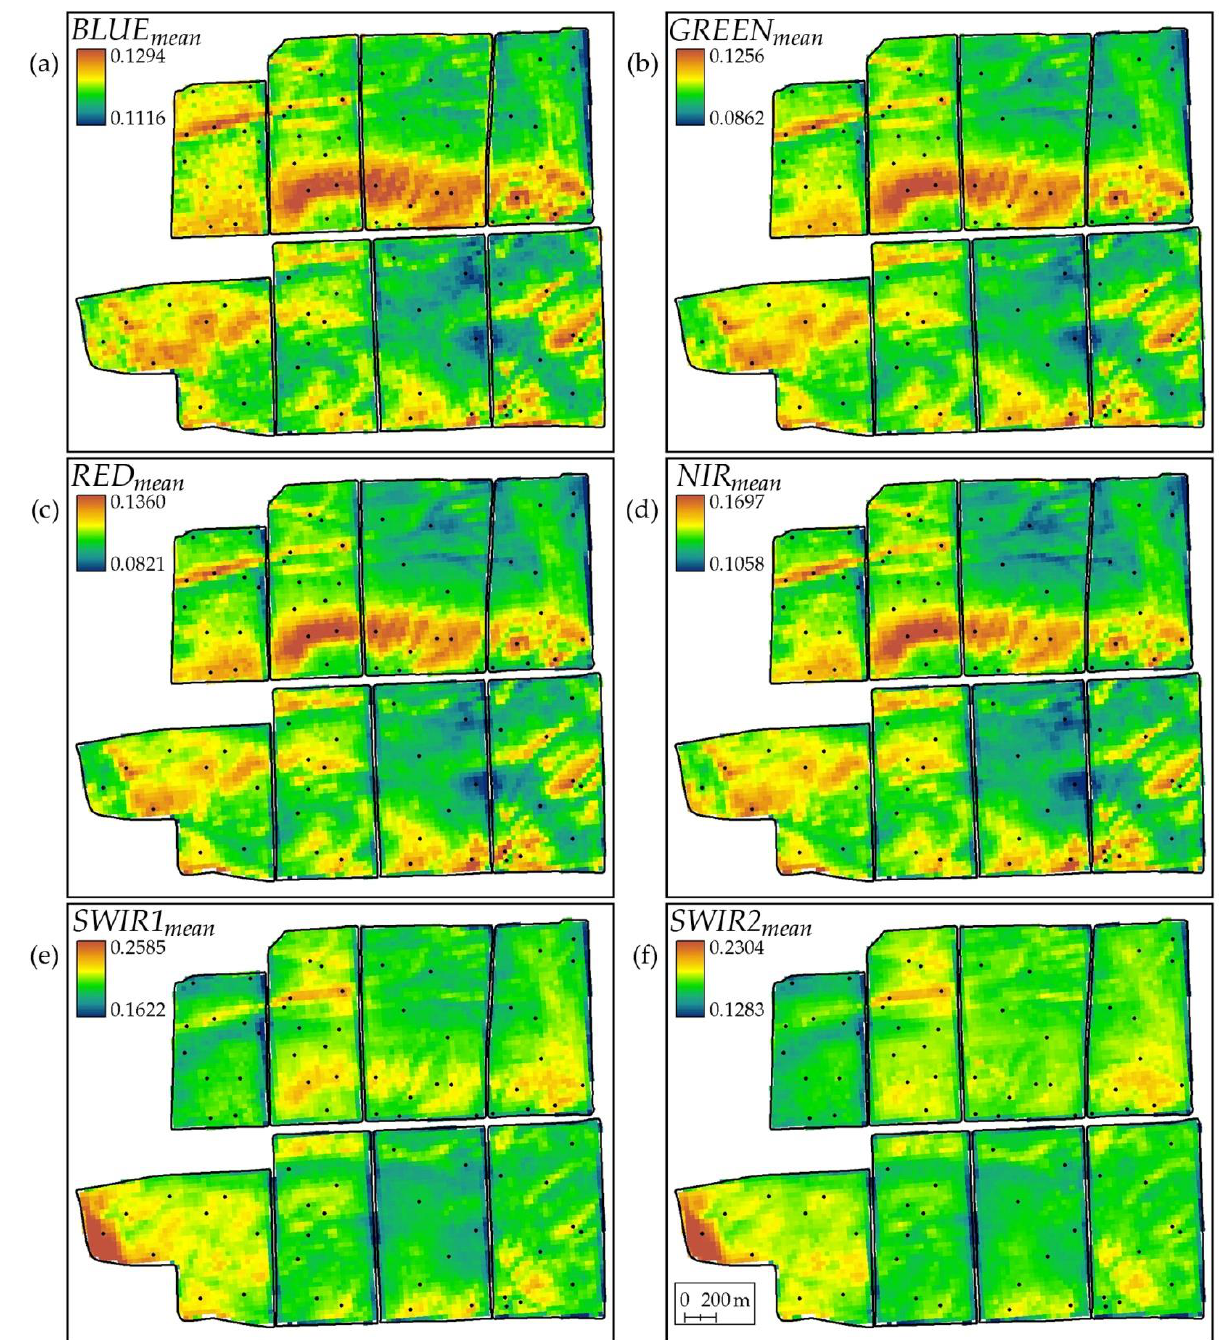
Figure 5. BAND mean values distributions.